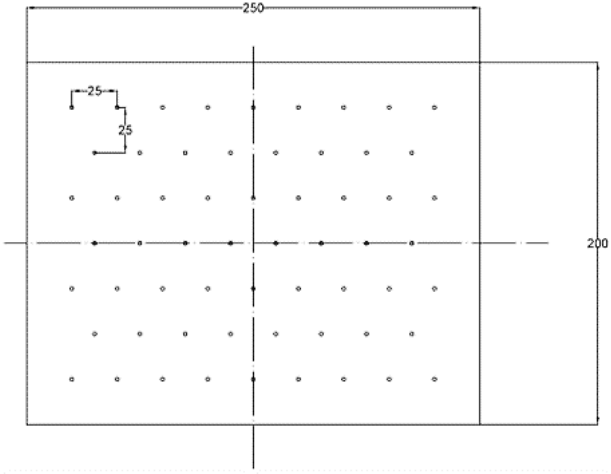
Figure 1. Hole-map design of the Al alloy sheet. Table 1. The different surface treatments applied to the Al alloy sheets. Sample ID.